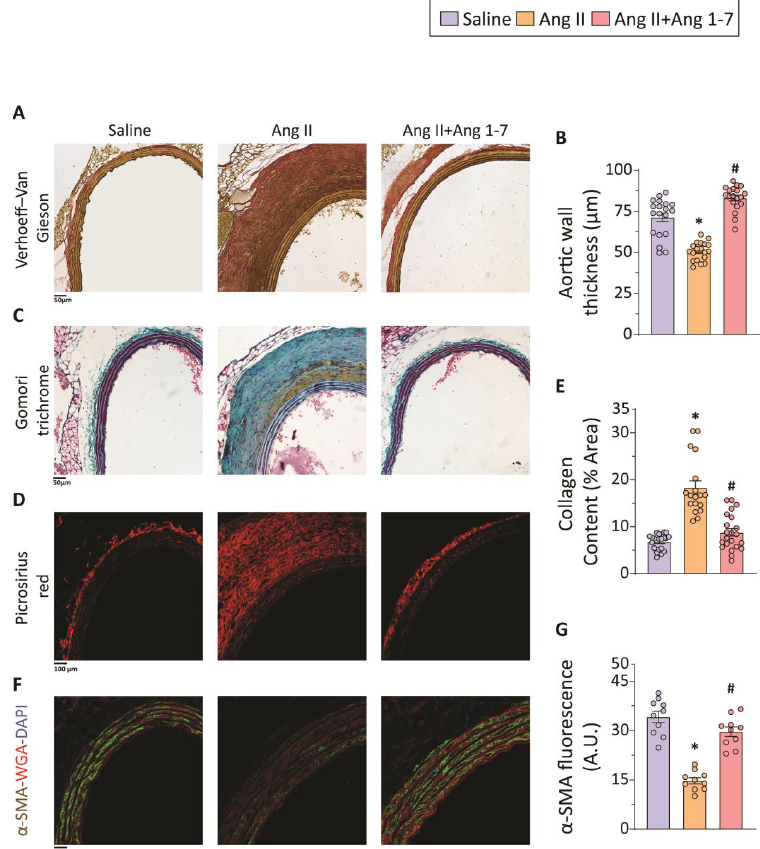
Figure 2. Attenuation of Ang II-induced adverse thoracic aortic remodeling by Ang 1-7 infusion. Representative images of Verhoeff–Van Gieson (elastin) staining and brightfield microscopy ( A ), and quantification of aortic media thickness ( B ) show significantly decreased medial thickness and increased medial degeneration in the thoracic aorta of ApoEKO mice in response to Ang II-infusion; chronic Ang 1-7 administration reduced medial degeneration and preserved thoracic aortic medial thickness. Representative images of Gomori trichrome staining and brightfield microscopy ( C ) and picrosirius red (collagen) staining and confocal microscopy ( D ), along with quantification of collagen content ( E ), indicate increased ECM remodeling in response to Ang II administration and abridged perivascular fibrosis resulting from chronic Ang 1-7 administration ( C – E ). Representative immunofluorescence and confocal microscopy images of α -SMA (green) and wheat-germ agglutinin (red) staining ( F ) of the thoracic aorta and quantification of α -SMA-immunoreactivity ( G ) exhibit reduced α -SMA fluorescence suggesting decreased contractile phenotype of VSMCs by Ang II administration and preservation of α - SMA levels by Ang 1-7 administration ( F , G ) in ApoEKO mice. Data points represent technical replicates from biological replicates (n = 3 in each group). * p < 0.05 compared with the saline group; # p < 0.05 compared with the Ang II group using one-way